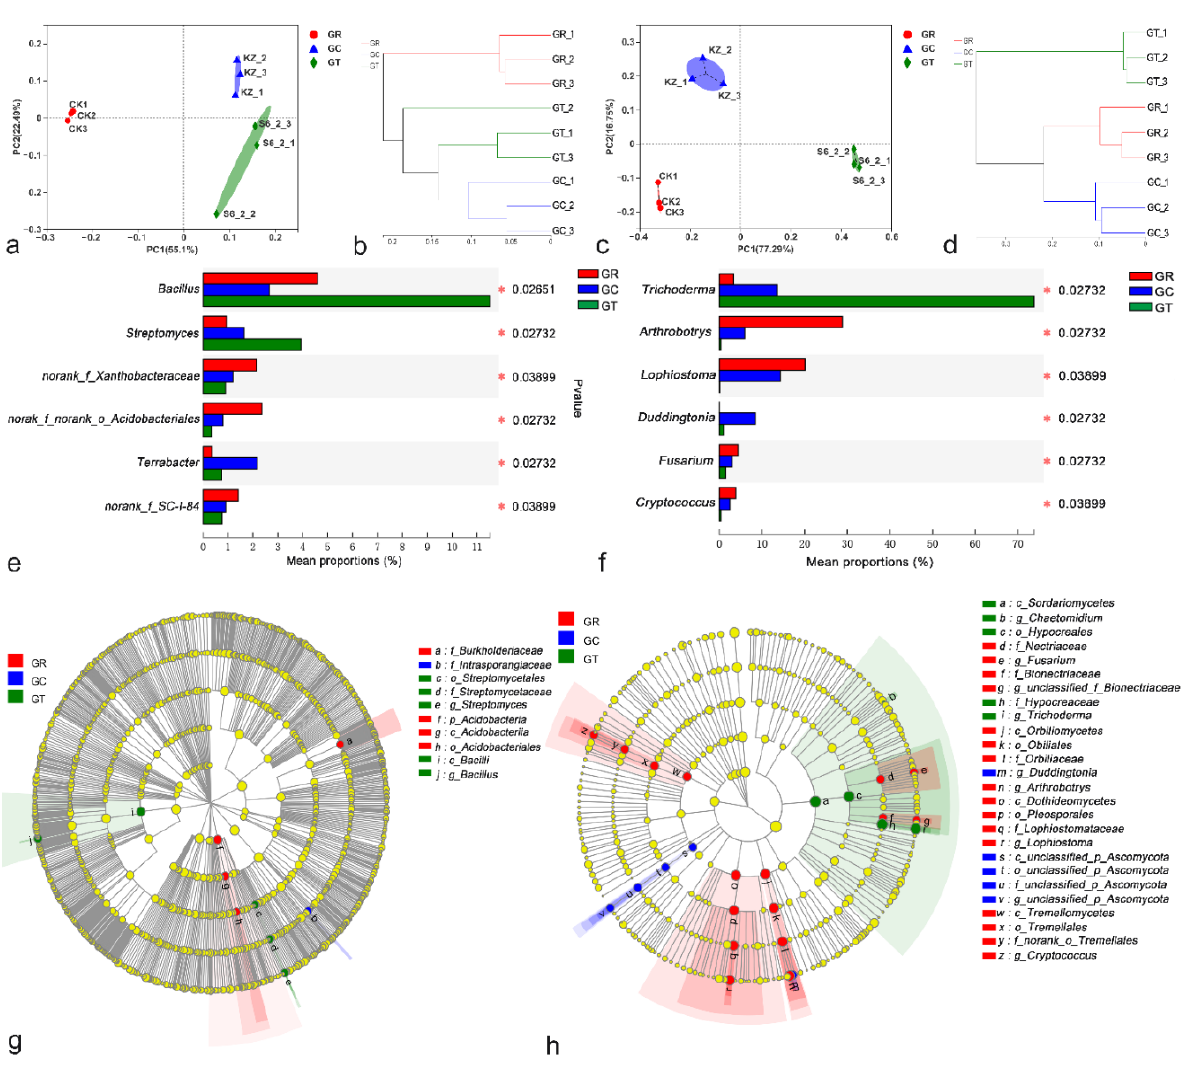
Figure 4. Principal coordinate analysis (PCoA) of the Bray–Curtis distance matrix at the genus level for the bacterial ( a ) and fungal ( c ) communities. Circles, triangles, and diamonds represent the GR, GC, and GT samples. Hierarchical clustering analysis at the genus level for bacteria ( b ) and fungi ( d ). Statistical comparisons of the relative abundances of bacteria ( e ) and fungi ( f ) at the genus level in different groups were performed using the Kruskal–Wallis test. Cladograms showing the phylo- genetic distribution of the bacterial ( g ) and fungal ( h ) lineages associated with the three treatments were generated by LEfSe analysis. Different colored regions represent different groups (red, GR; blue, GC; green, GT). Circles indicate phylogenetic levels from phylum to genus. The diameter of each circle is proportional to the abundance of the group.